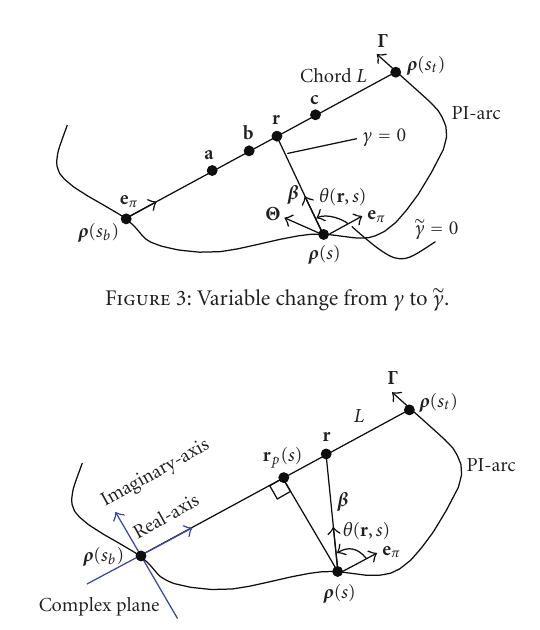
Figure 4: Complex coordinate system for the analytic